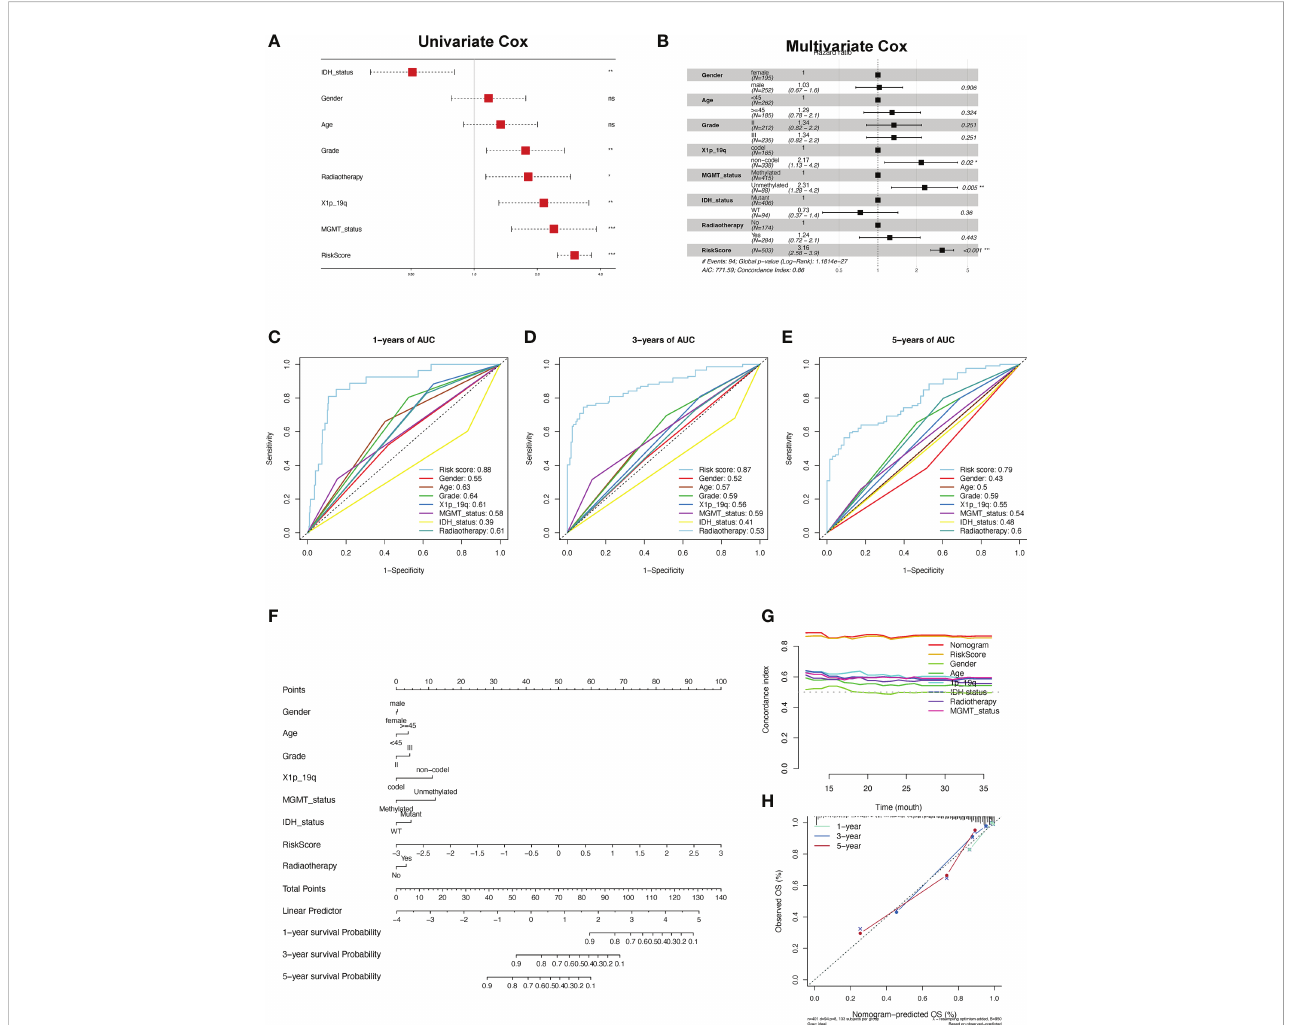
FIGURE 8 Construction and validation of the nomogram. (A, B) Univariate and multifactor Cox regression analysis between the risk scores and clinical features. (C-E) ROC analyses of the risk score for the prediction of overall survival status at 1 (C) , 3 (D) , and 5 years (E) . (F) Predicting the probabilities of survival via nomogram at 1, 3, and 5 years in the TCGA-LGG cohort. (G) The concordance index for predicting the probabilities for clinical features using the nomogram. (H) The calibration curve plots for predicting 1-, 3-, and 5-year OS in LGG patients in the TCGA